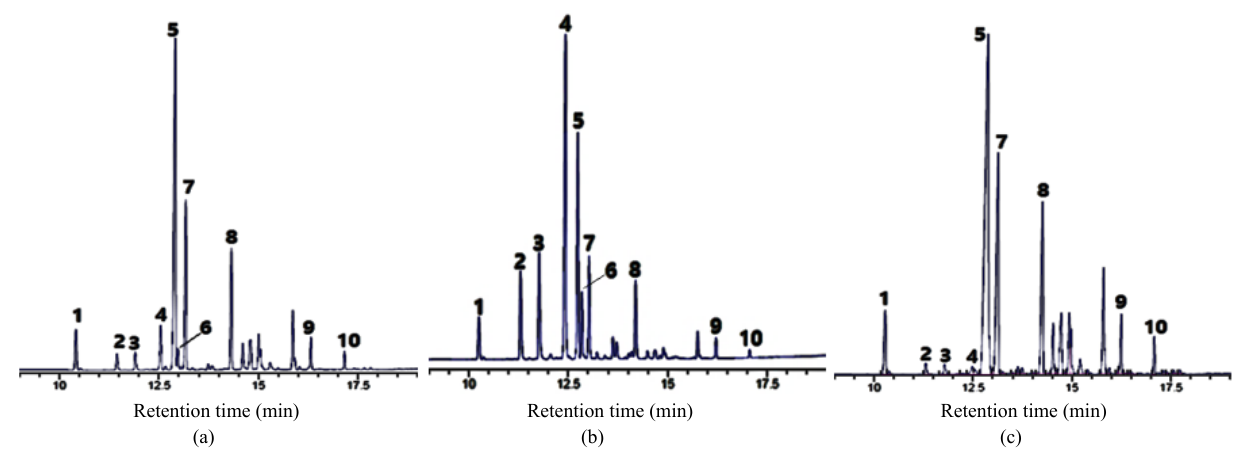
ㅍ Figure 2. Gas chromatogram of (a) feed (wash oil), (b) mixed extract phase recovered through by n = 1⁓5 ( ∑ 𝐸 E n ) and (cid:2873) n = 1 (cid:3041) ) (cid:3041)(cid:2880)(cid:2869) , and (c) raffinate phase (R 5 ) recovered